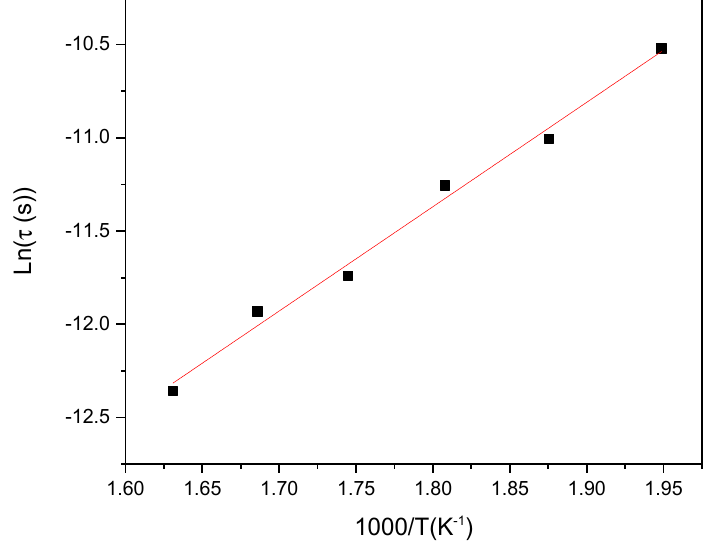
Figure 16. Variation of relaxation time versus 1000/T for TZV15 sample.